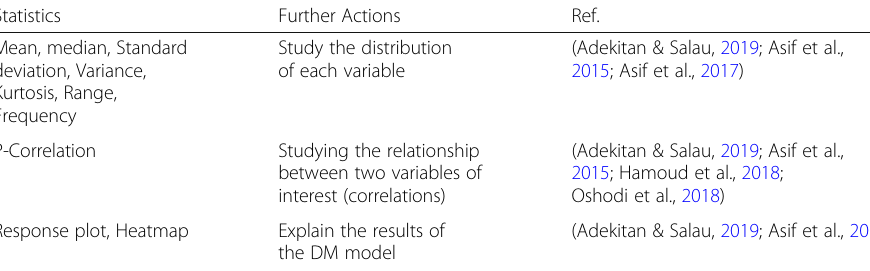
Table 10 Descriptive results and consequent decision